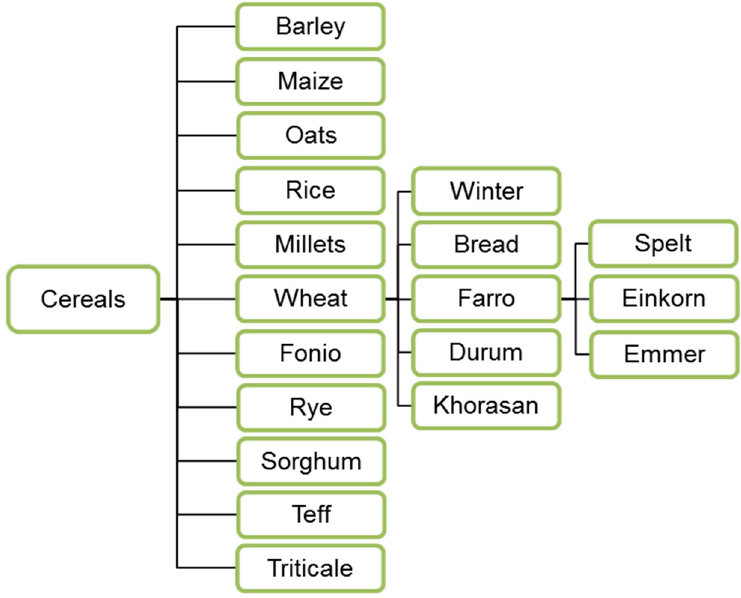
Figure 1. The most frequently used cereals for feed and food processing. Table 1. Cereals and pseudocereals grain/seeds content (g per 100 g).